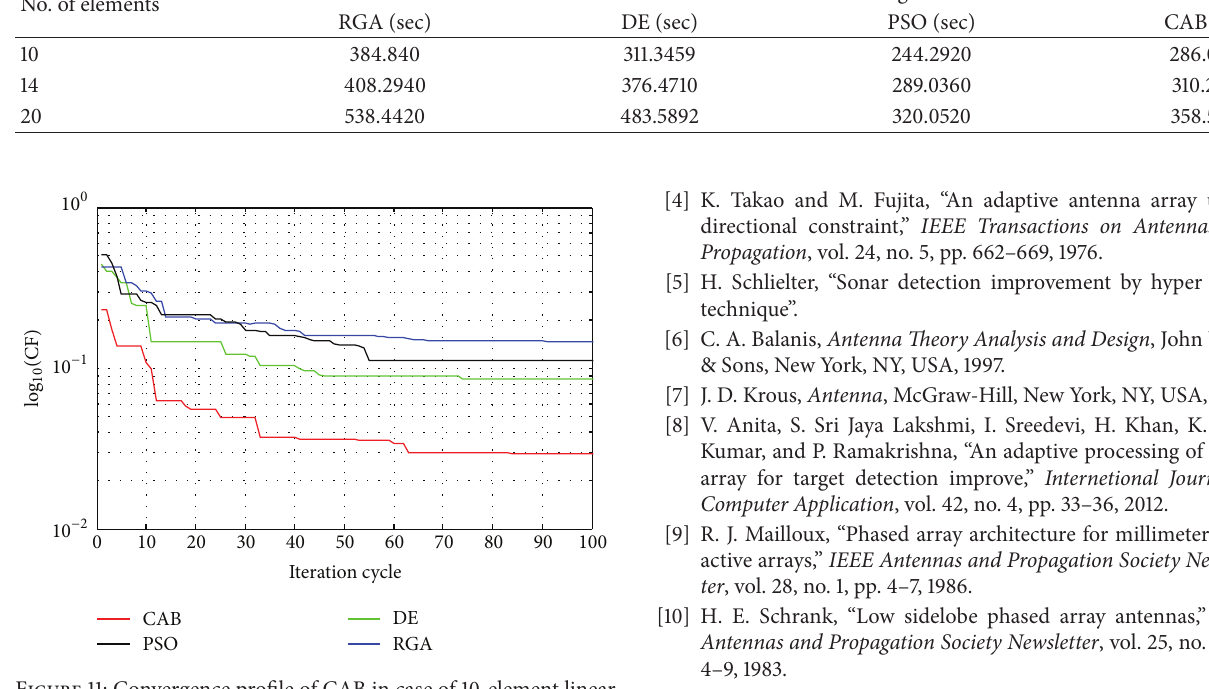
Figure 11: Convergence profile of CAB in case of 10-element linear antenna array at 𝑢 = 1